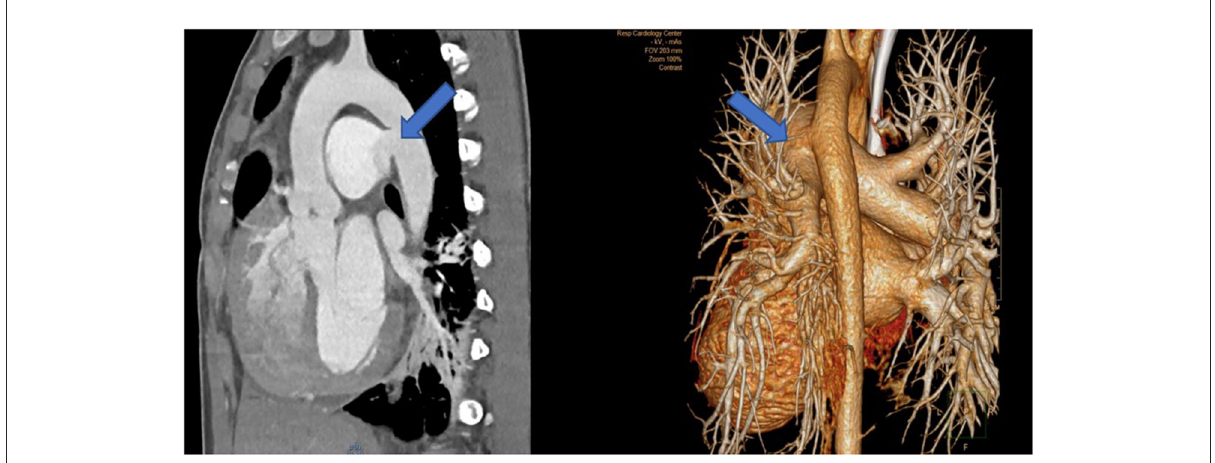
FIGURE7 Left: CT-angiography with a large patent ductus with a 2.5 cm confluence into the proximal descending aorta, functionally looking like an aorto-pulmonary window. Right: View in the 3-D reconstruction with the blue arrow demonstrating the site of the communication.